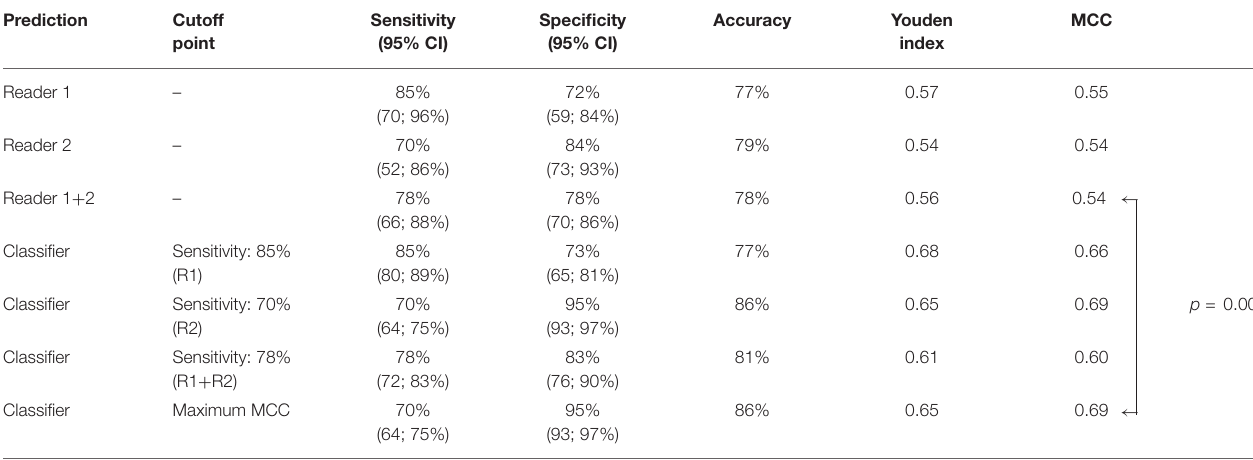
TABLE 2 | Classification performance metrics of radiologist readers and machine learning classifier.